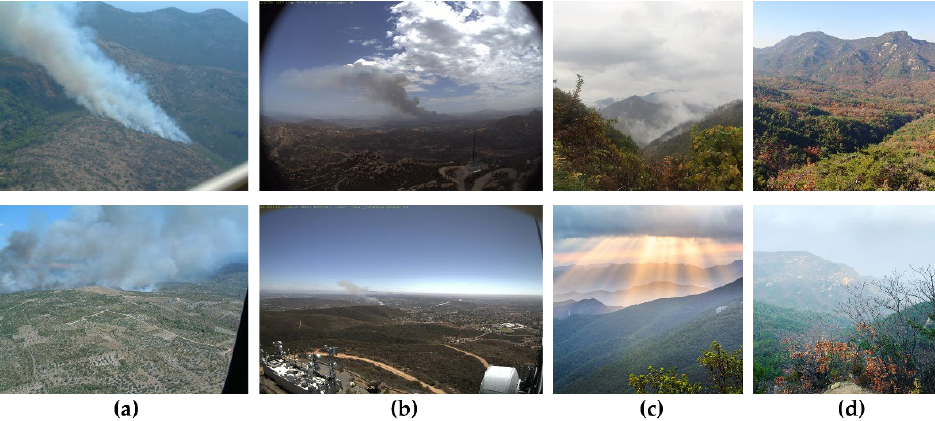
Figure 7. Sample image of wildfire smoke dataset. ( a ) Large and medium size smoke images, ( b ) small-size smoke images, ( c ) non-smoke such as fog and cloud images, ( d ) non-smoke wildland images. Table 1. Wildfire smoke dataset and its